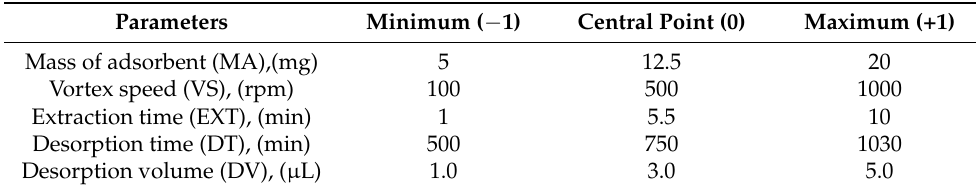
Table 1. Parameters and levels used in 2 5 − 1 fractional factorial design for extraction and pre- concentration of ACT.